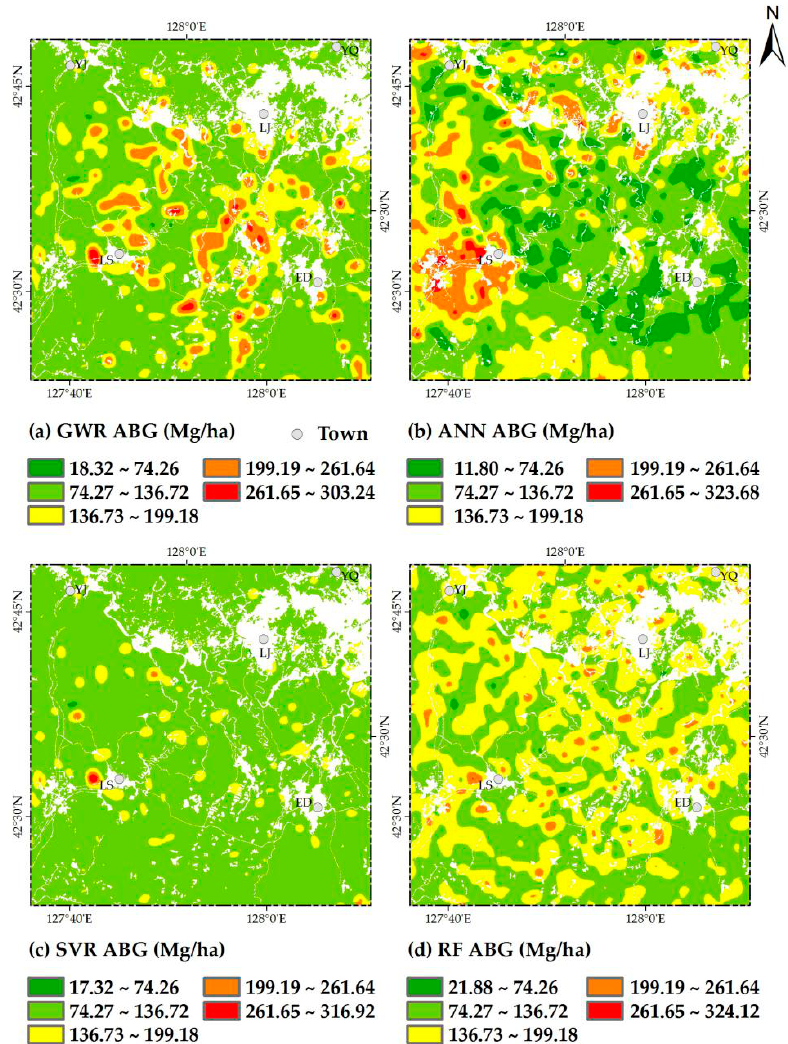
Figure 6. Predicted maps of above-ground biomass in the study site derived from ( a ) geographically weighted regression (GWR), ( b ) multi-layer perception neural network (ANN), ( c ) support vector machines for regression (SVR), and ( d ) random forests (RF). YJ, YQ, LJ, LS, and ED are the abbreviations of Yanjiang, Yongqing, Liangjiang, Lushuihe, and Erdaobaihe towns, respectively.